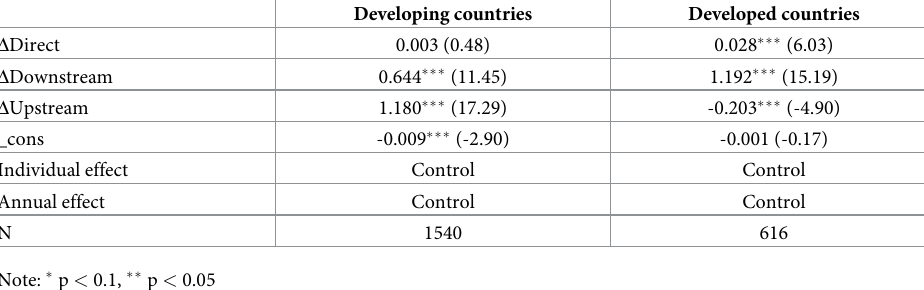
Table 5. Heterogeneity analysis results of developed countries and developing